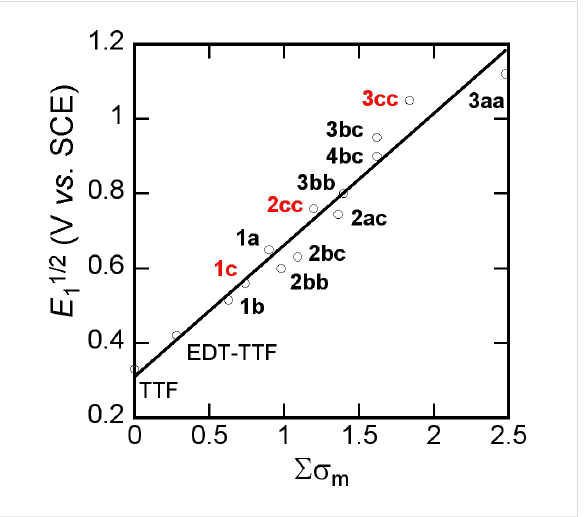
Figure 1: Correlation between the first oxidation potential E 1/2 and the sum of the Hammet σ meta parameters. TTF that only contain only CF 3 EWG are given in